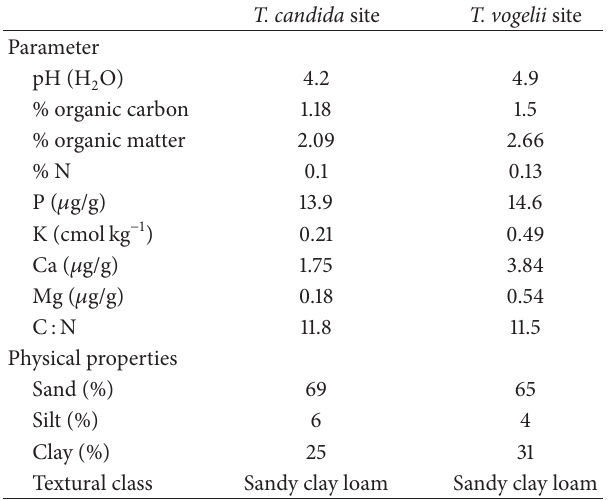
Table 1: Initial physicochemical soil properties at the study area (0– 20 cm